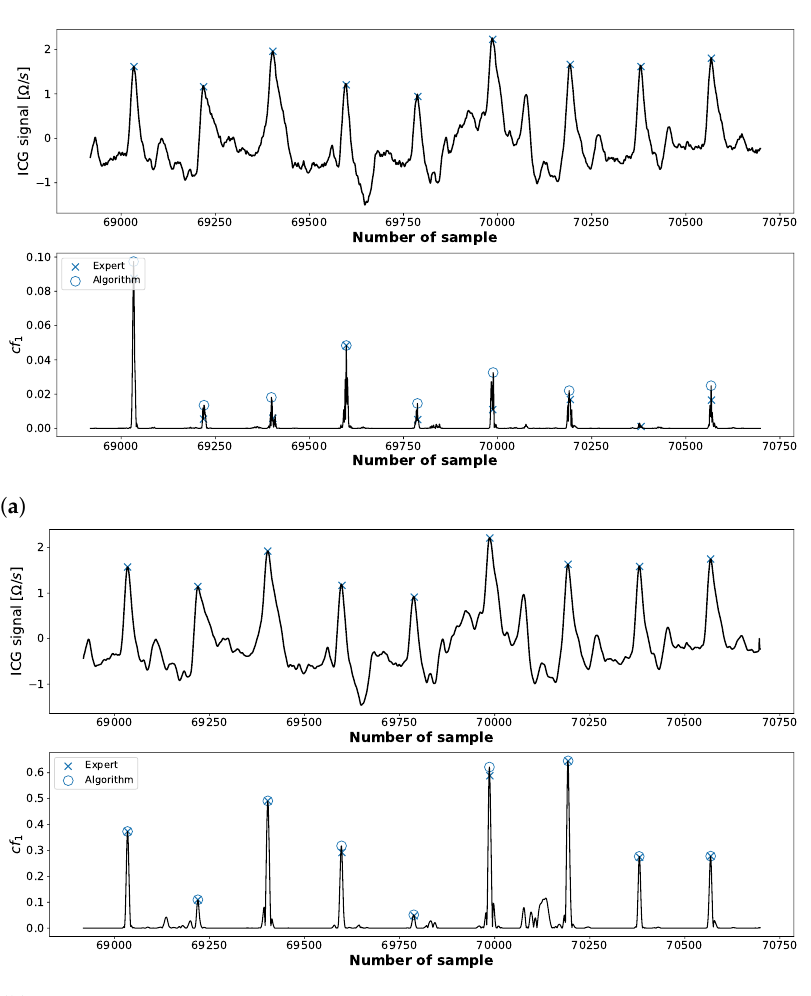
Figure A1. The positions of the C points identified in the ICG signal without ( a ) and with additional filtering ( b ). ( a ) A fragment of the ICG signal (upper figure) in which one C point was missed during the process of its identification in the cf 1 (Equation (6) series. ( b ) The same signal as in ( a ) but after application of a mean filter.